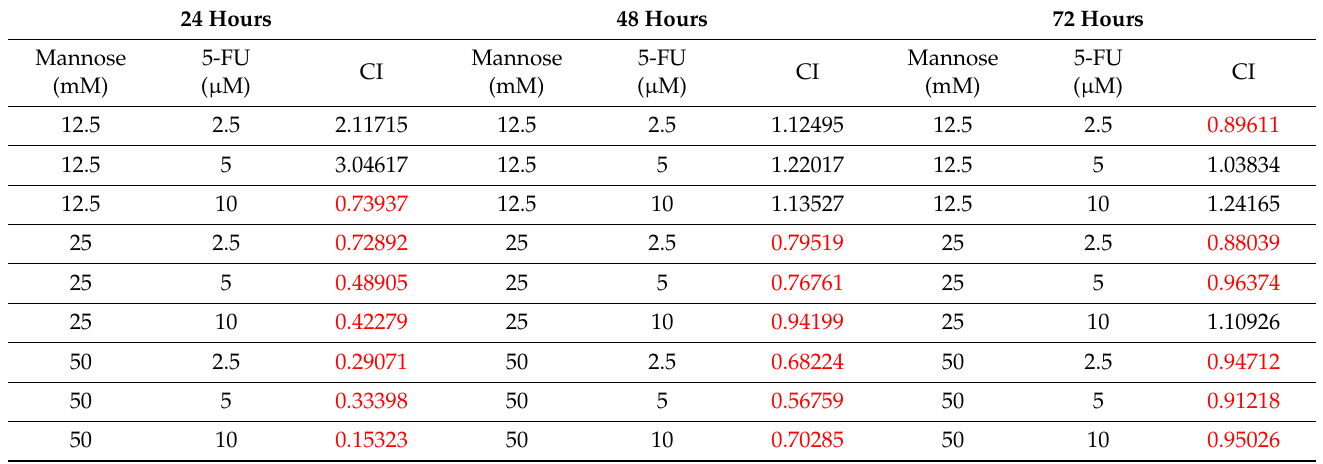
Figure 3. Mannose and 5-FU combination treatments display synergistic interactions in HCT116 cells. Results are expressed as a percentage of control and represent the average of three independent experiments ± SEM. The asterisk represents the lowest concentration showing a significant decrease in cell viability in treated versus control cells. Significance from the control is indicated by ** p < 0.01, and *** p < 0.001. Table 2. Mannose and 5-FU Compusyn study on HCT116-treated cells. Combination index (CI) values of CI = 1 additive effect, CI < 1 synergistic, and CI > 1 antagonistic. Red values indicate synergistic